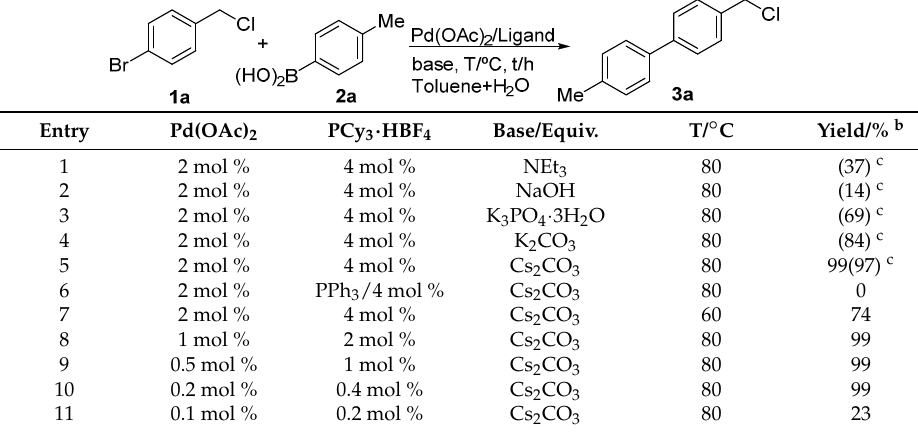
Table 1. Optimized reaction conditions a .